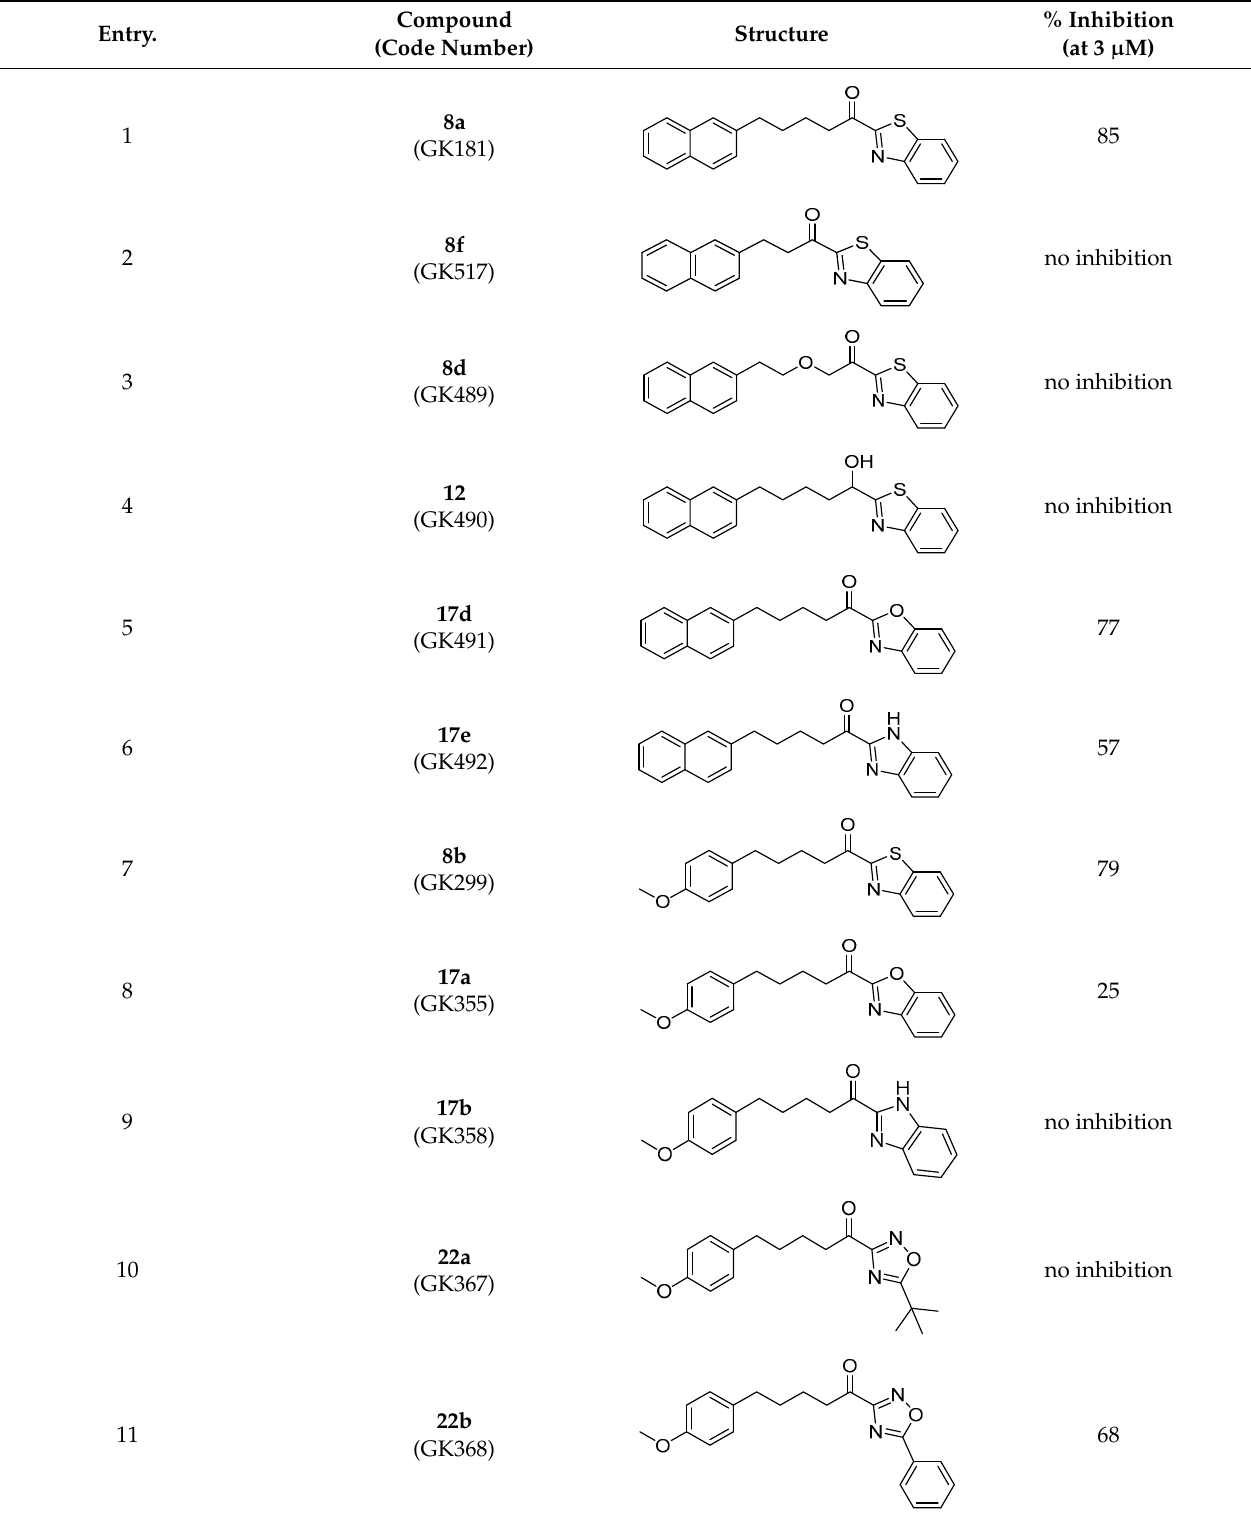
Table 1. Compounds tested for their inhibition of PGE 2 generation at 3 µ M.